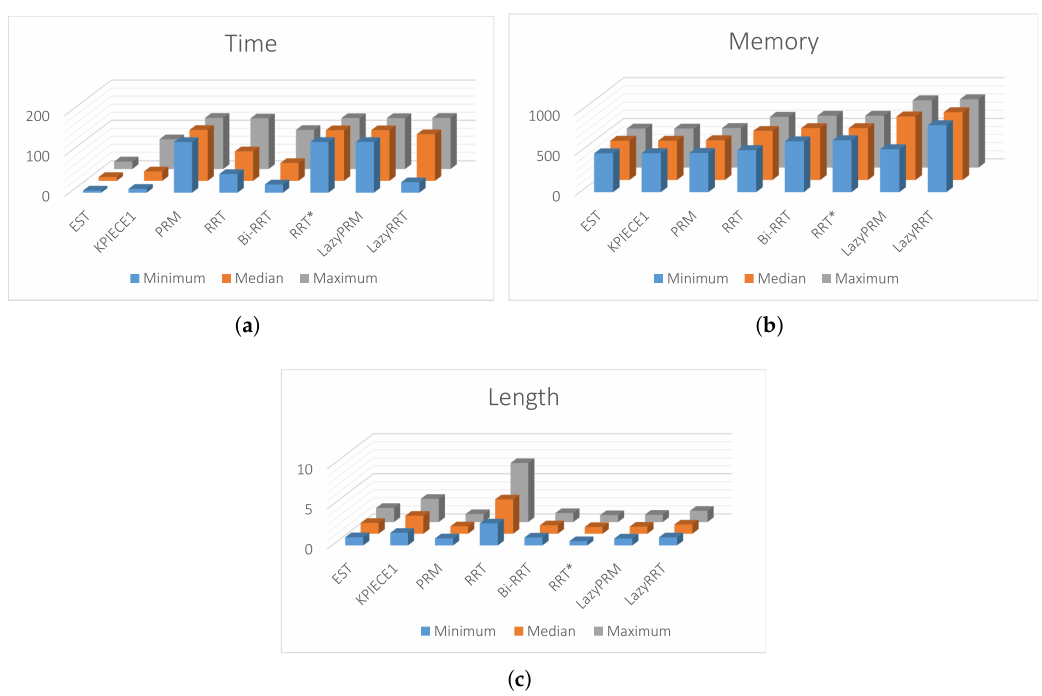
Figure 32. Bar graphs for time, length of path, and memory in number of times respect to the MGHPPM results of case 3. ( a ) Execution time. ( b ) Memory. ( c ) Length of path.